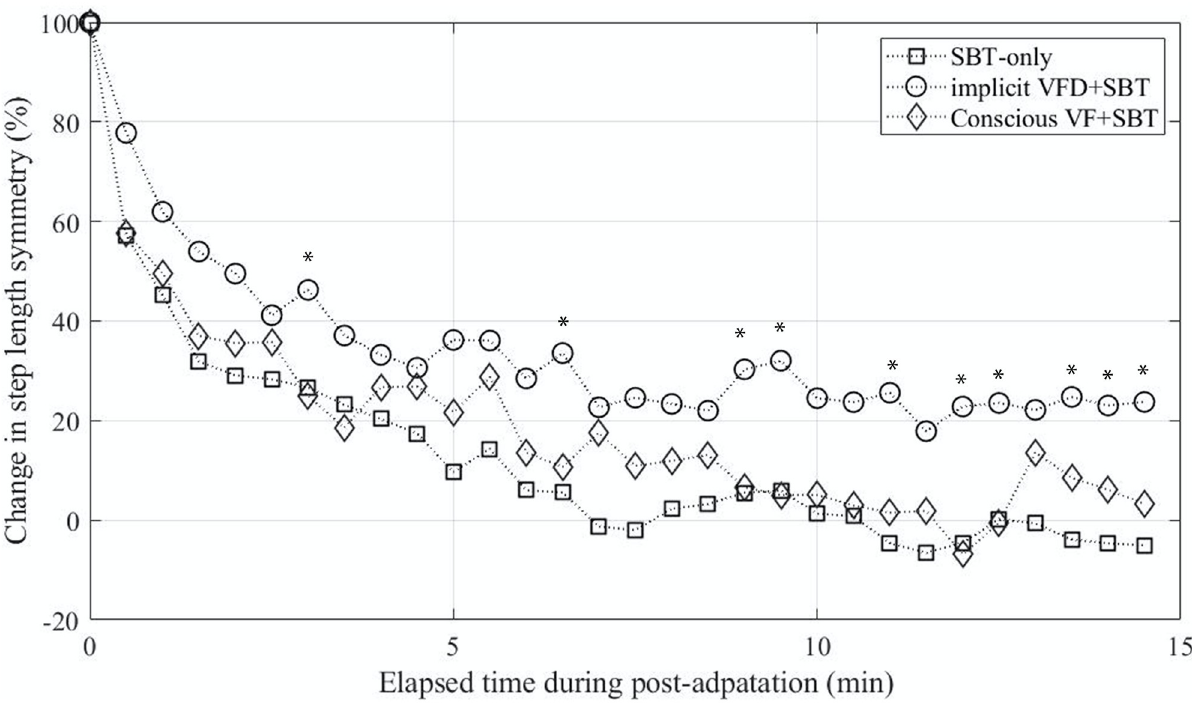
Fig 5. Change in step length symmetry during the post-adaptation period. Group means step length symmetry values (19 subjects for the SBT-only, 16 subjects for the implicit VFD+SBT, and 12 subjects for the conscious VF+SBT) were normalized by the initial values (100%). Displaying standard deviation and significant differences were ignored in this plot (refer to Figs 3A and